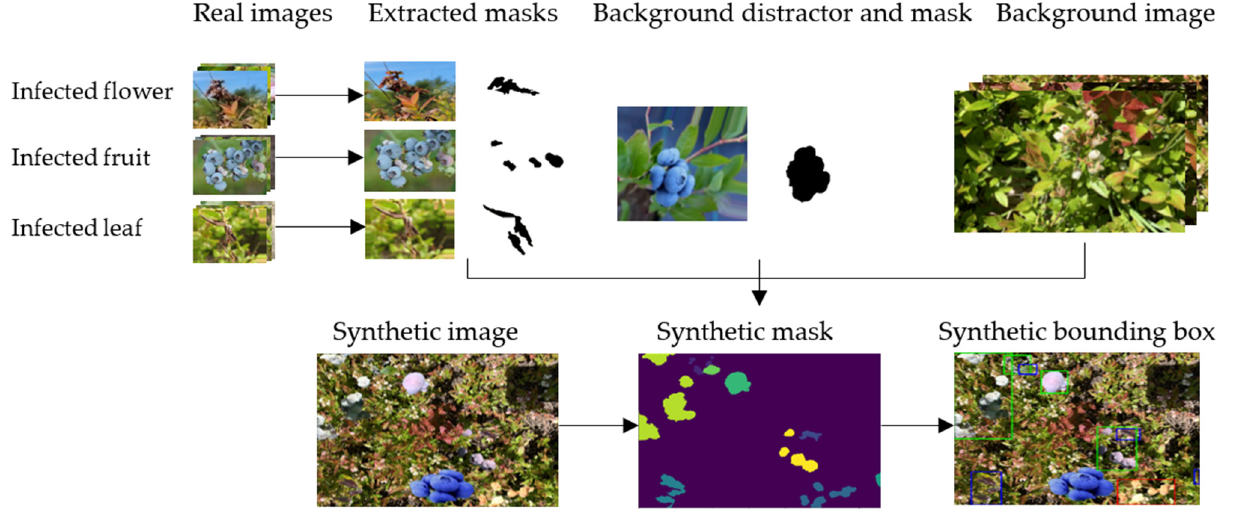
Figure 2. The procedure of synthetic image dataset generation.